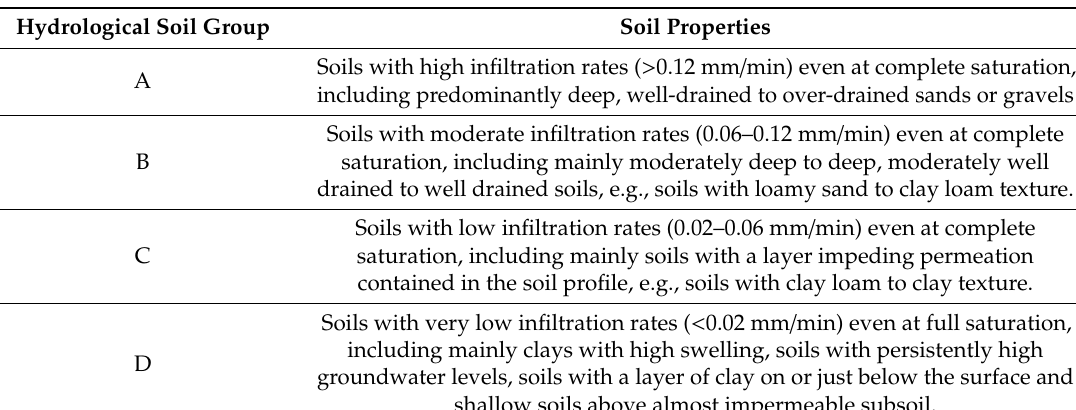
Table 1. Description of hydrologic soil groups [34].